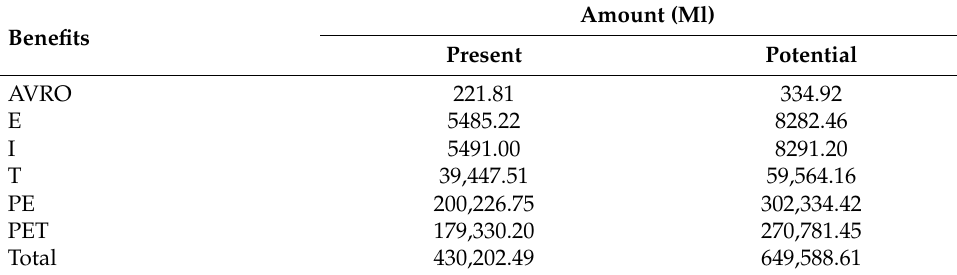
Figure 2. Tree benefits: ( a ) amount of air pollution absorbed expressed in carbon monoxide (CO), nitrogen dioxide (NO 2 ), Ozone (O 3 ), particulate matter (PM10 and PM2.5) and sulfuric dioxide (SO 2 ); ( b ) carbon annually sequestrated and carbon stored in trees’ lifetime. Table 4. Hydrological benefits from tree coverage in megalitres (Ml).